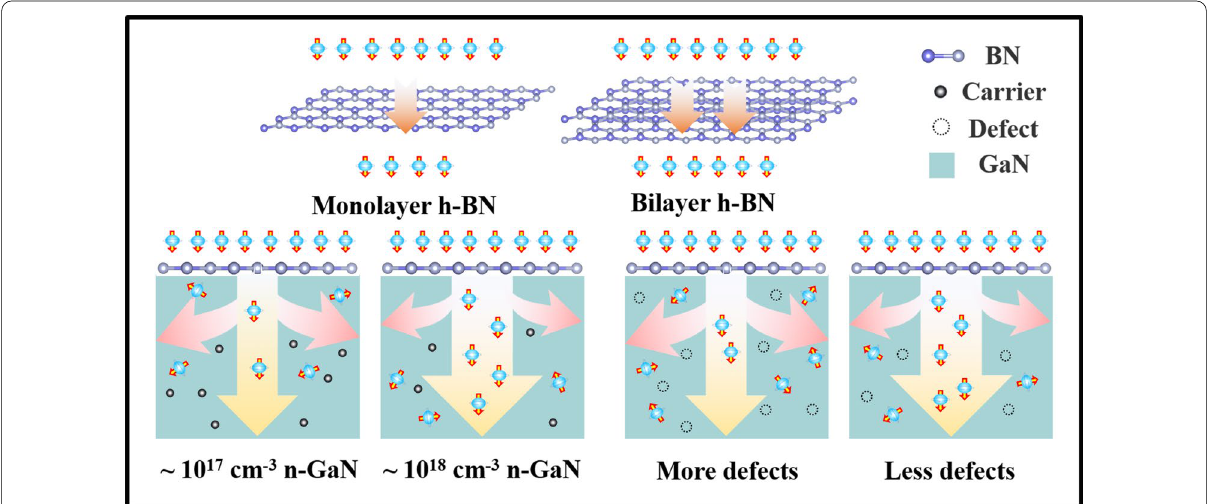
Fig. 5 Schematic showing the effects of h-BN layer number, carrier concentration and crystal equality of GaN on the spin injection and